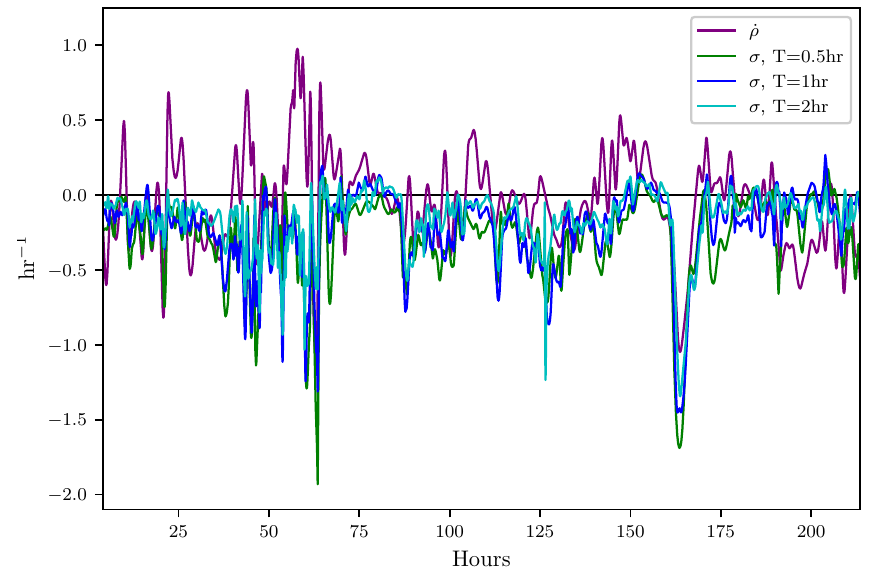
Figure 8. Comparison of the trajectory divergence rate with the 0.5,1, and 2 h backward-time finite-time Lyapunov exponent (FTLE) from t = 4 to t = 215 h. FTLE fields have been multiplied by − 1 to offer better comparison of attraction.